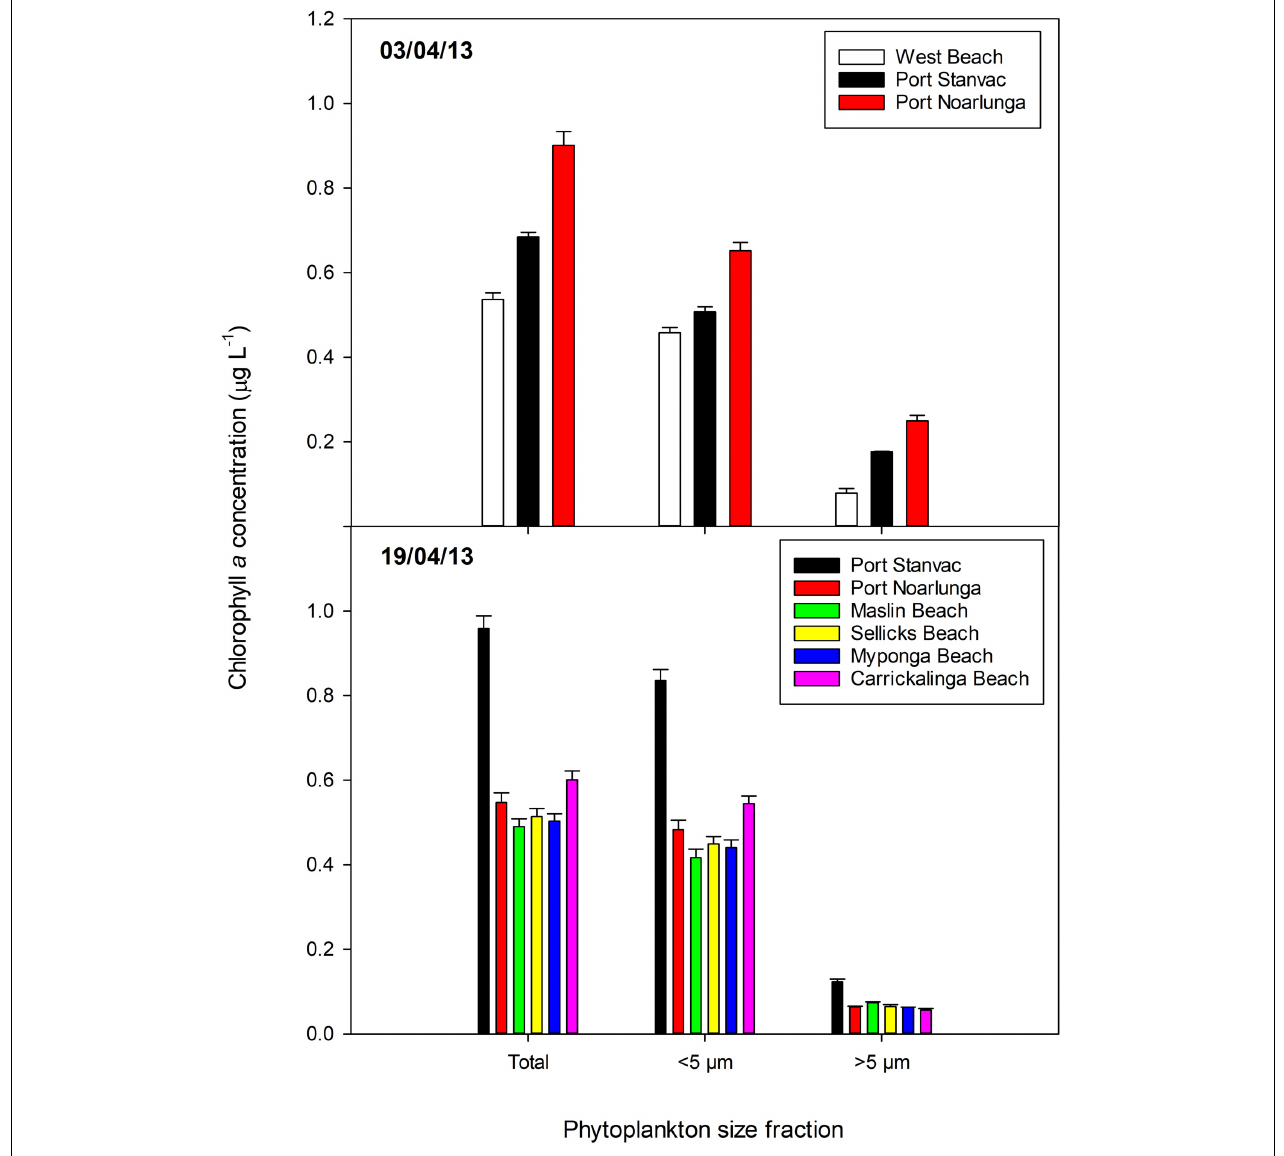
FIGURE 4 | Total chlorophyll a concentrations, and concentrations in the small ( < 5 µ m) and large ( > 5 µ m) size fractions of phytoplankton biomass in samples collected in Gulf St Vincent on 3 and 19 April 2013. Mean ± standard error. Station locations are displayed in Table 2